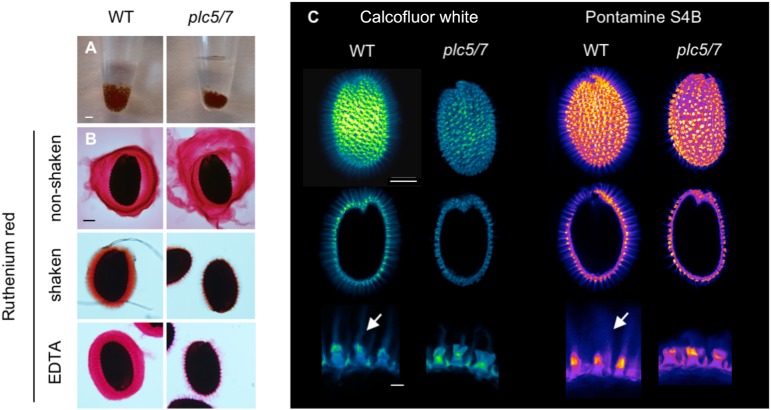
Seeds of plc5/7-double mutant exhibit a mucilage defect. (A) Seeds of plc5/7 swell less than WT during imbibition. Equal amounts of dry seeds of WT and mutant were immersed in water O/N and photographed the next day. (B) Ruthenium red staining of wild type- and plc5/7 seeds without shaking (top), with shaking (middle), or EDTA treatment (bottom). ’With’ shaking shows adherent mucilage layer; ’without’ shaking displays both adherent and non-adherent mucilage layers. (C) Cellulose staining by Calcofluor white (left panel) or Pontamine B (right panel) in wild type- and plc5/7 seeds. Confocal images of whole seeds, cross section, and close-up views (top, middle and bottom, respectively) are shown. Bars represent 2 mm (A), or 0.1 mm (top and middle rows) or 0.025 mm (bottom row) (B). Representative results of at least 3 biological replicates are shown.